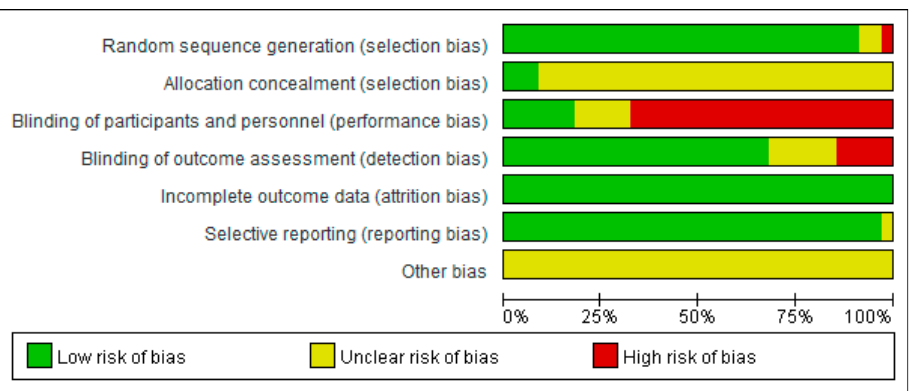
Figure 2. Risk of bias summary: review authors’ judgments of bias items for each included study [12–45].